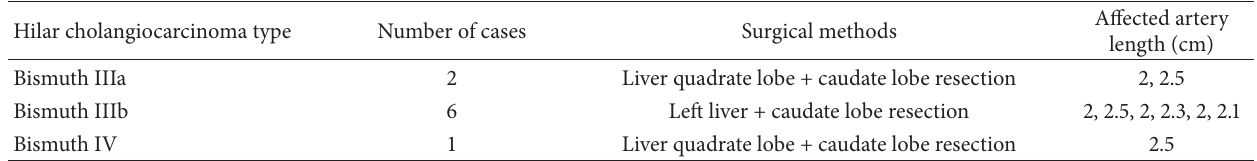
Table 1: Gastroduodenal artery bridging for hepatic artery